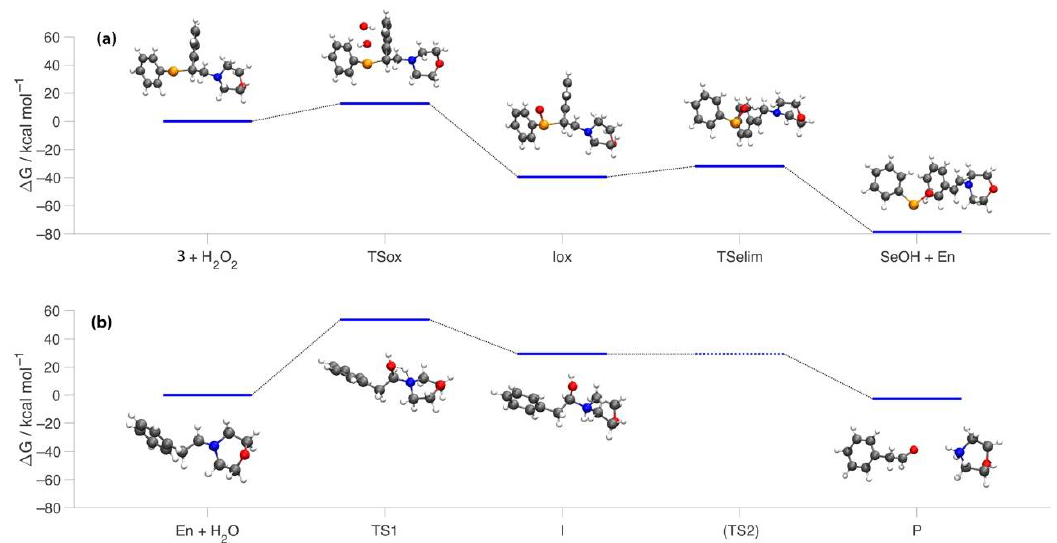
Figure 1. Gibbs free energies of the relevant intermediates and transition states characterized in water for the oxidation and subsequent elimination of compound 3 : ( a ) corresponds to the top reaction of Scheme 1 whereas ( b ) to the bottom one. Water and hydrogen peroxide molecules are not shown in the minimum energy structures for clarity. Level of theory: COSMO- ZORA-OLYP/TZ2P.